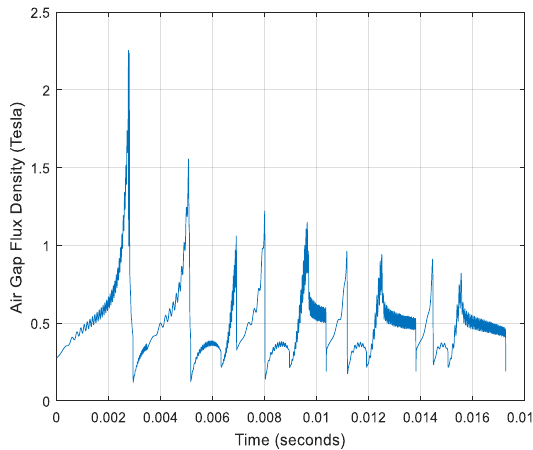
Figure 4. Air gap flux density in time domain (machine with 1 mm crack).